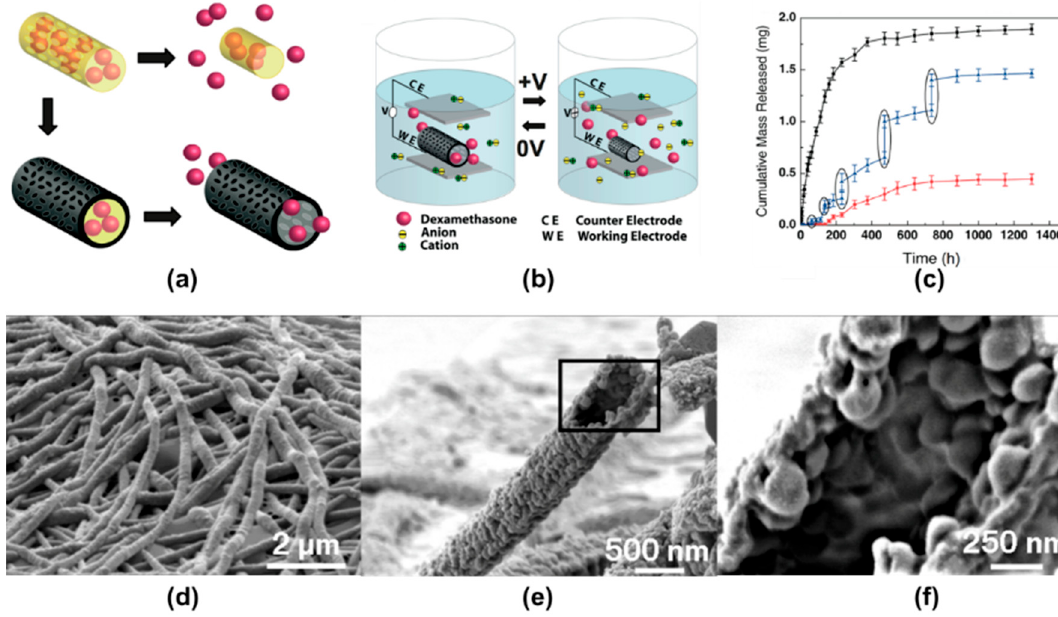
Figure 11. A schematic of the release of dexamethasone from the PLGA nanofiber and the PEDOT-coated PLGA nanofiber ( a ). A mechanism of drug release resulting from contraction of the PEDOT nanotube by a positive applied voltage ( b ). Cumulative mass of dexamethasone released over time from the PLGA nanofibers (black), the PEDOT/PLGA nanofibers with no electrical stimulation (red), and the PEDOT/PLGA nanofibers when 1 V was applied at five specific points ( c ). Scanning electron micrographs of the PEDOT nanotubes after removal of PLGA ( d – f ). Adapted